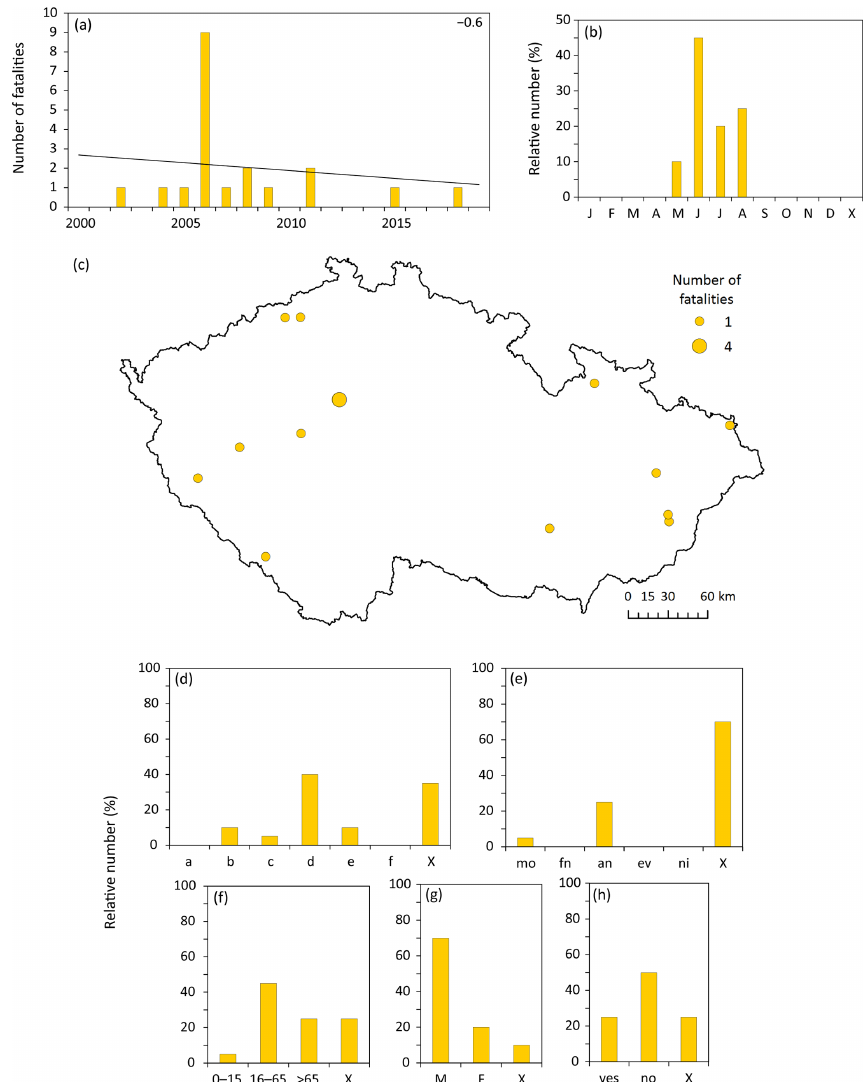
Figure 8. Characteristics of heat-related fatalities in the Czech Republic during the 2000–2019 period: (a) fluctuation with linear trend (top right, fatalities/10 years), (b) annual variation, (c) spatial distribution (four fatalities lack exact location), (d) place of death, (e) part of the day, (f) age, (g) sex, (h) behaviour. For explanation of symbols and abbreviations see Fig.